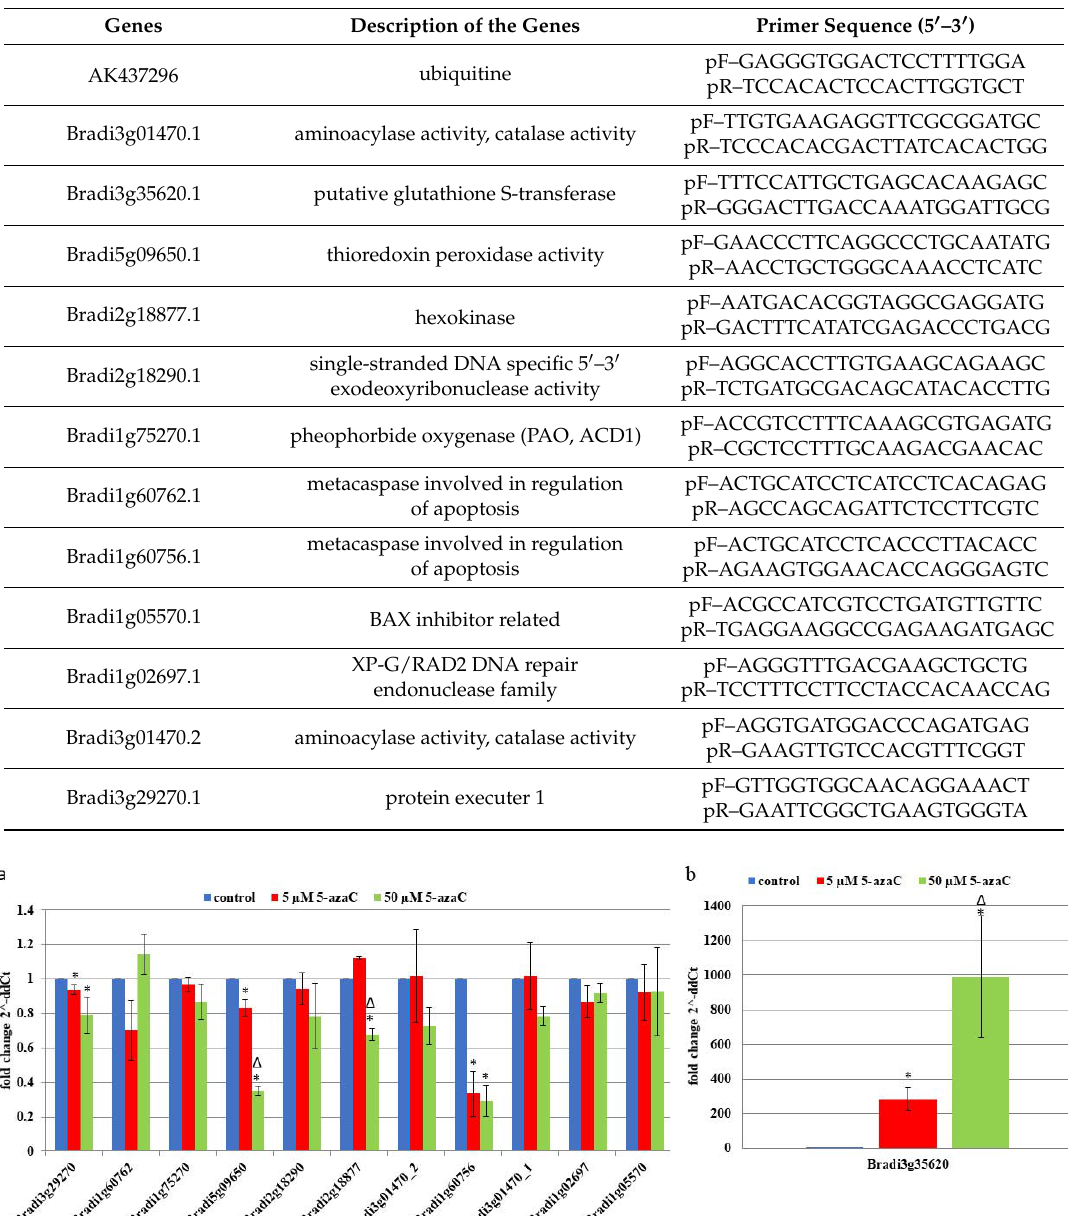
Table 1. Oligonucleotide primers used for RT-PCR reaction with the relevant description of the genes. Genes Description of the Genes Primer Sequence (5 (cid:48) –3 (cid:48) )